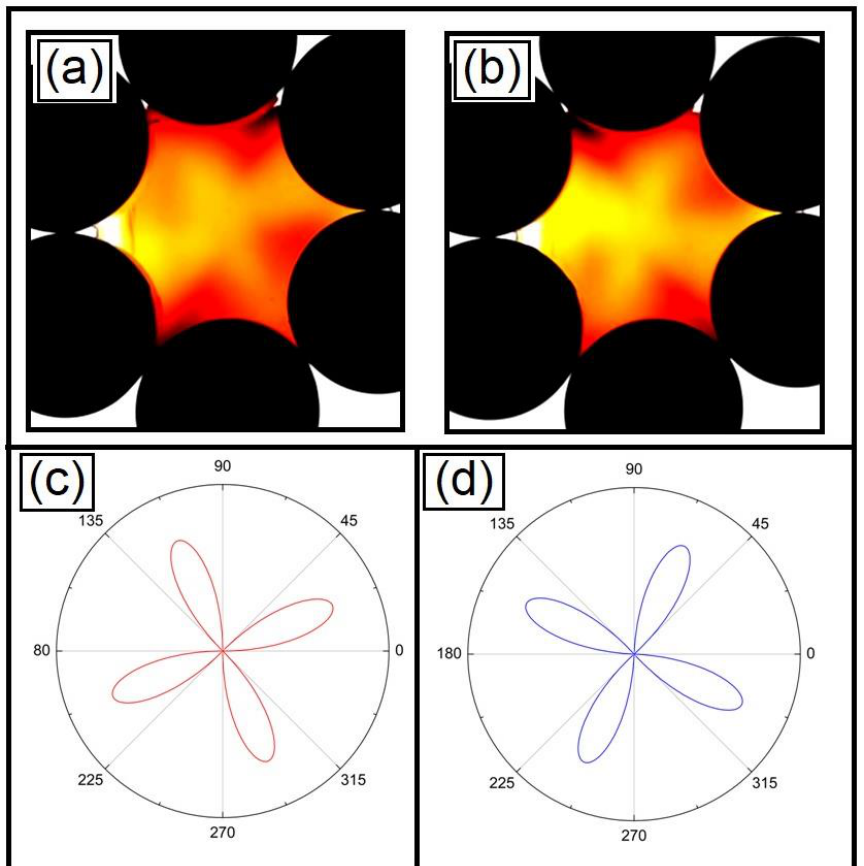
Figure 11. Circular polarization in Ferrocell for a sextupolar magnetic field. The light entering the Ferrocell is linearly polarized light. In ( a ) we have the light that emerges from the Ferrocell being analyzed with a circular polarizer to the right, and in ( b ) the light is analyzed with a circular polarizer oriented to the left. In ( c ) we have the graph in polar coordinates of the light intensity for the case of the image in ( a ), while in ( d ) we have the graph in polar coordinates for the intensity of light for the case in ( d ).